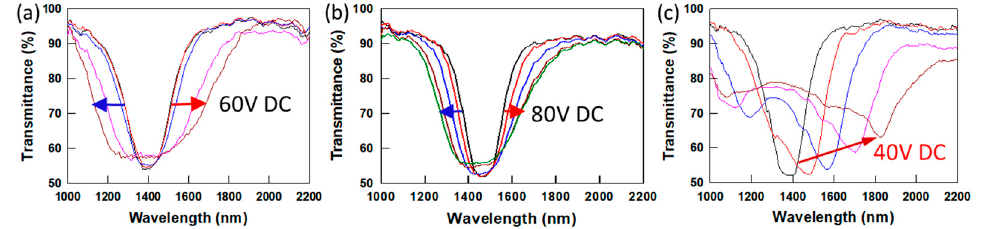
Figure 5. Transmission spectra of PSCLCs formulated with 3.5 wt% R1011, 90.5 wt% MLC-2079 and